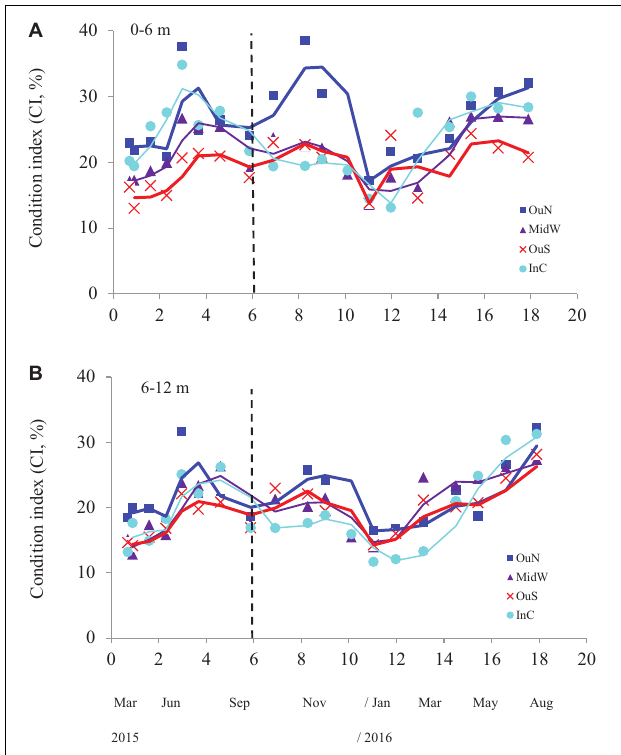
FIGURE 5 | Condition index of the cultivated mussels at the four different locations in the Ría de Arousa throughout the whole cultivation cycle (moving average) and at two depth intervals: (A) 0–6 m (A) and (B) 6–12 m. The dashed line represents the timing of the thinning out process usually carried out between seeding and harvest.